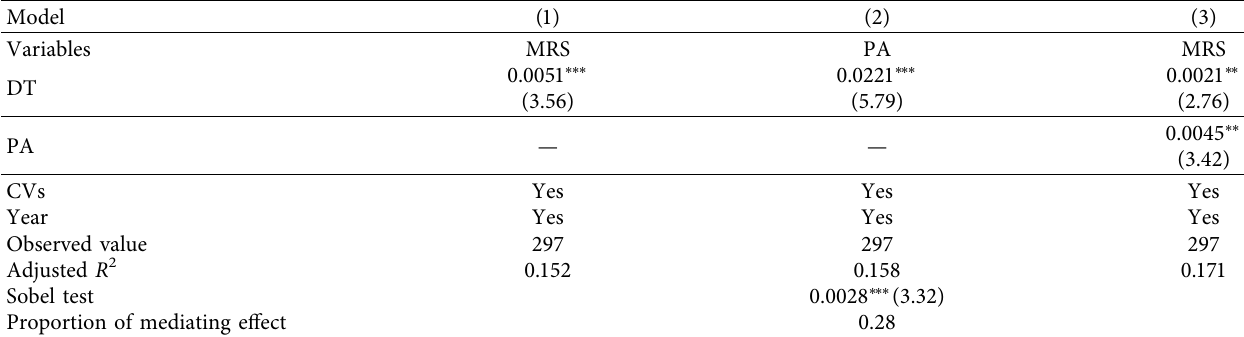
Table 8: Mediating effect of innovation